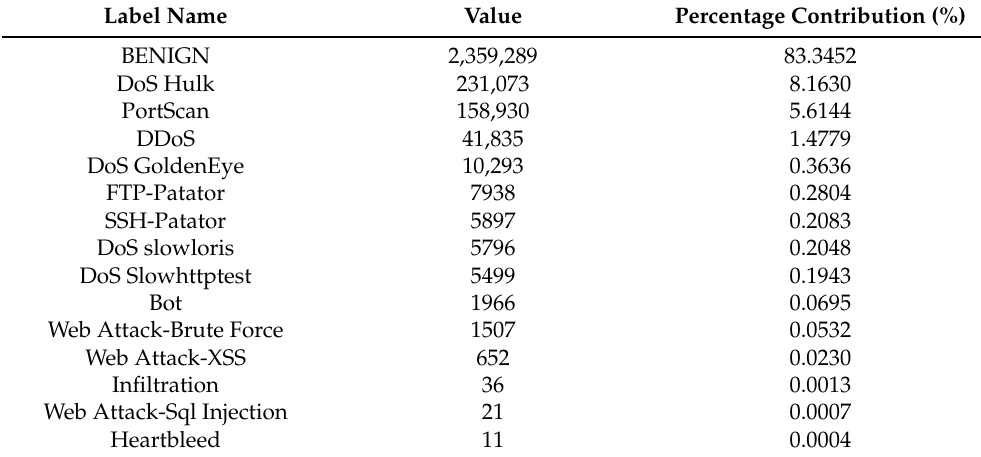
Table 2. Distribution of stream records in CICIDS2017 dataset.